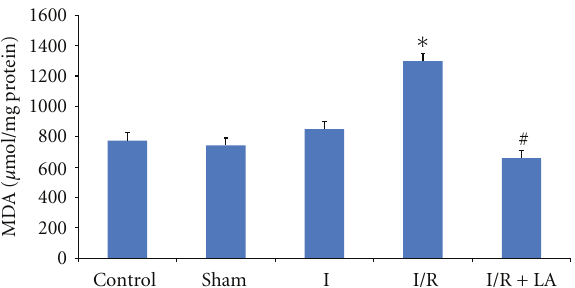
Figure 3: E ff ects of ischemia/reperfusion (2h torsion 720 ◦ in a clockwise direction and 2h detorsion of the testis) and LA (100mg/kg ip, 30minutes prior to detorsion) on MDA levels of rat testes. Data are mean ± SEM: ∗ P < 0 . 05 compared with control and sham groups, # P < 0 . 05 compared with I/R group.